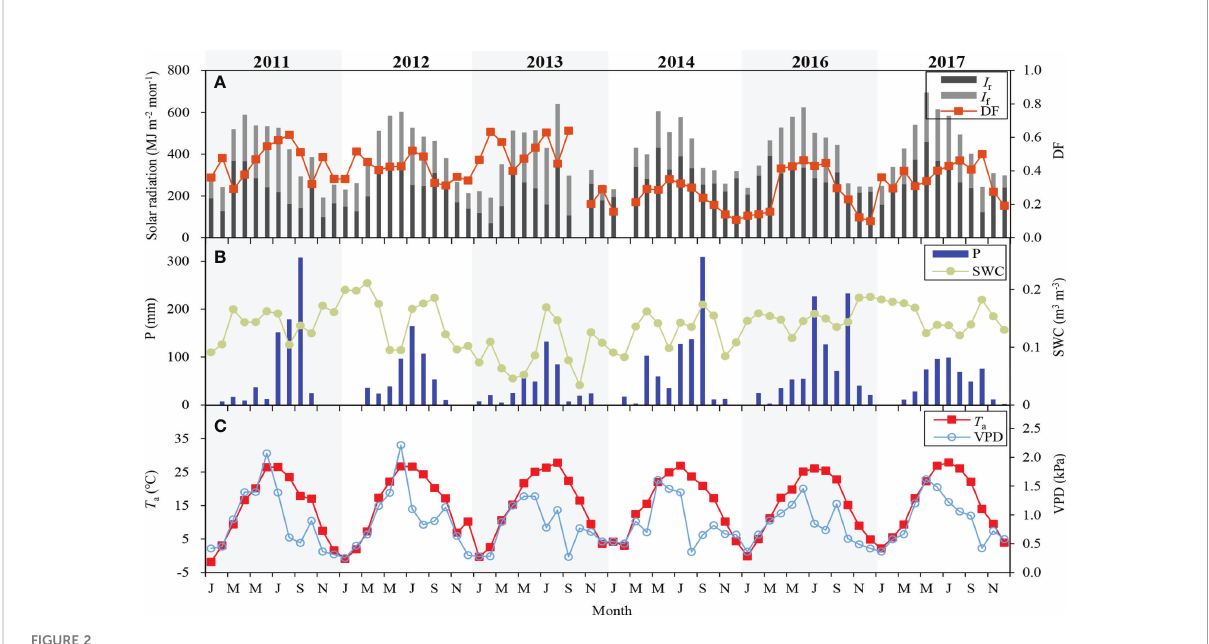
CA B FIGURE 2 Monthly variations of (A) diffuse radiation ( I f ), direct radiation ( I r ), diffuse fraction (DF), (B) precipitation (P), soil water content (SWC), (C) air temperature ( T a ) and vapor pressure difference FIGURE 3 Seasonal variation in monthly (A) gross primary productivity (GPP) and photosynthetically active radiation (PAR), (B) light use ef fi ciency (LUE) during the 6-year period.